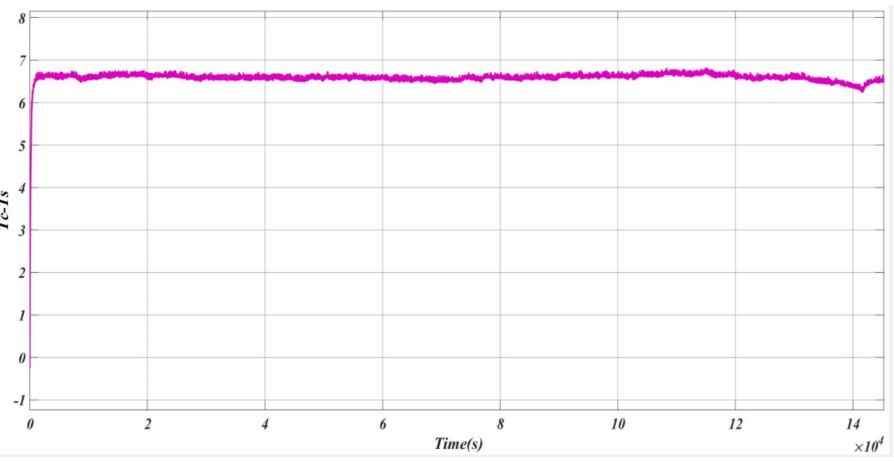
Figure 10. Variation of the difference between the estimated T c and measured T s